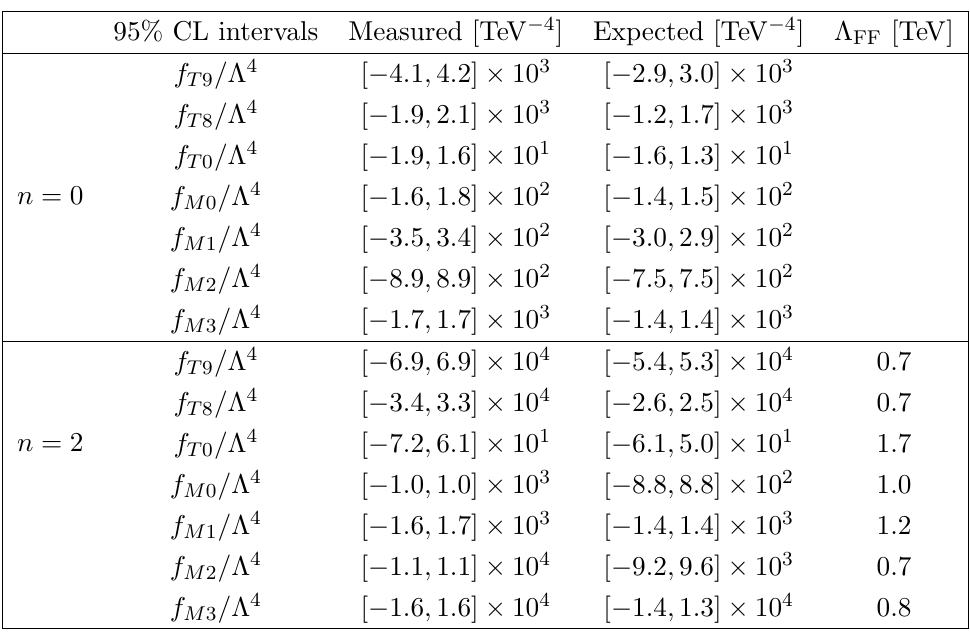
Table 9 . Measured and expected one-dimensional 95% con(cid:12)dence level intervals on aQGC param- eters (in the Vbfnlo formalism) using the combination of all Z(cid:13)jj channels (charged-lepton and neutrino). The FF exponent n = 0 entries correspond to an in(cid:12)nite FF scale and therefore result in non-unitarized 95% CL intervals. FF exponent n = 2 con(cid:12)dence intervals preserve unitarity with individual form-factor scales as shown in the last column for each dimension-8 operator. The maximum allowed form-factor values (cid:3) FF are chosen, according to the unitarity bounds calculated by Vbfnlo and are also reported in this table. The latest NLO cross-section prediction of Vbfnlo is used in the aQGC parameterization